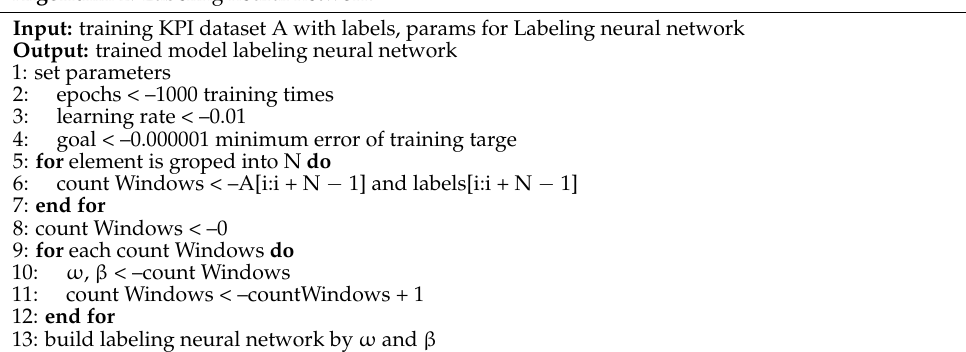
Algorithm 2: Labeling neural